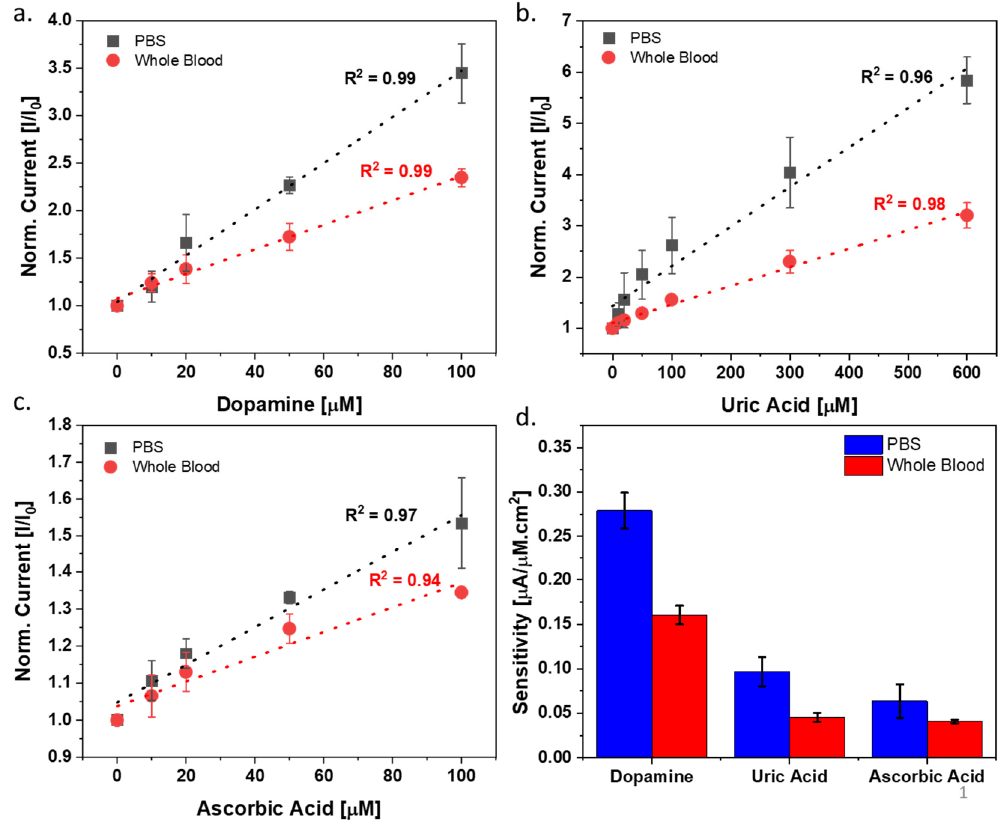
Figure 4. Electrochemical response curves of ( a ) DA; ( b ) UA; and ( c ) AA in 0.1 M PBS and whole blood (from mice). ( d ) Sensitivity of the O3ES towards each individual analyte in PBS and whole